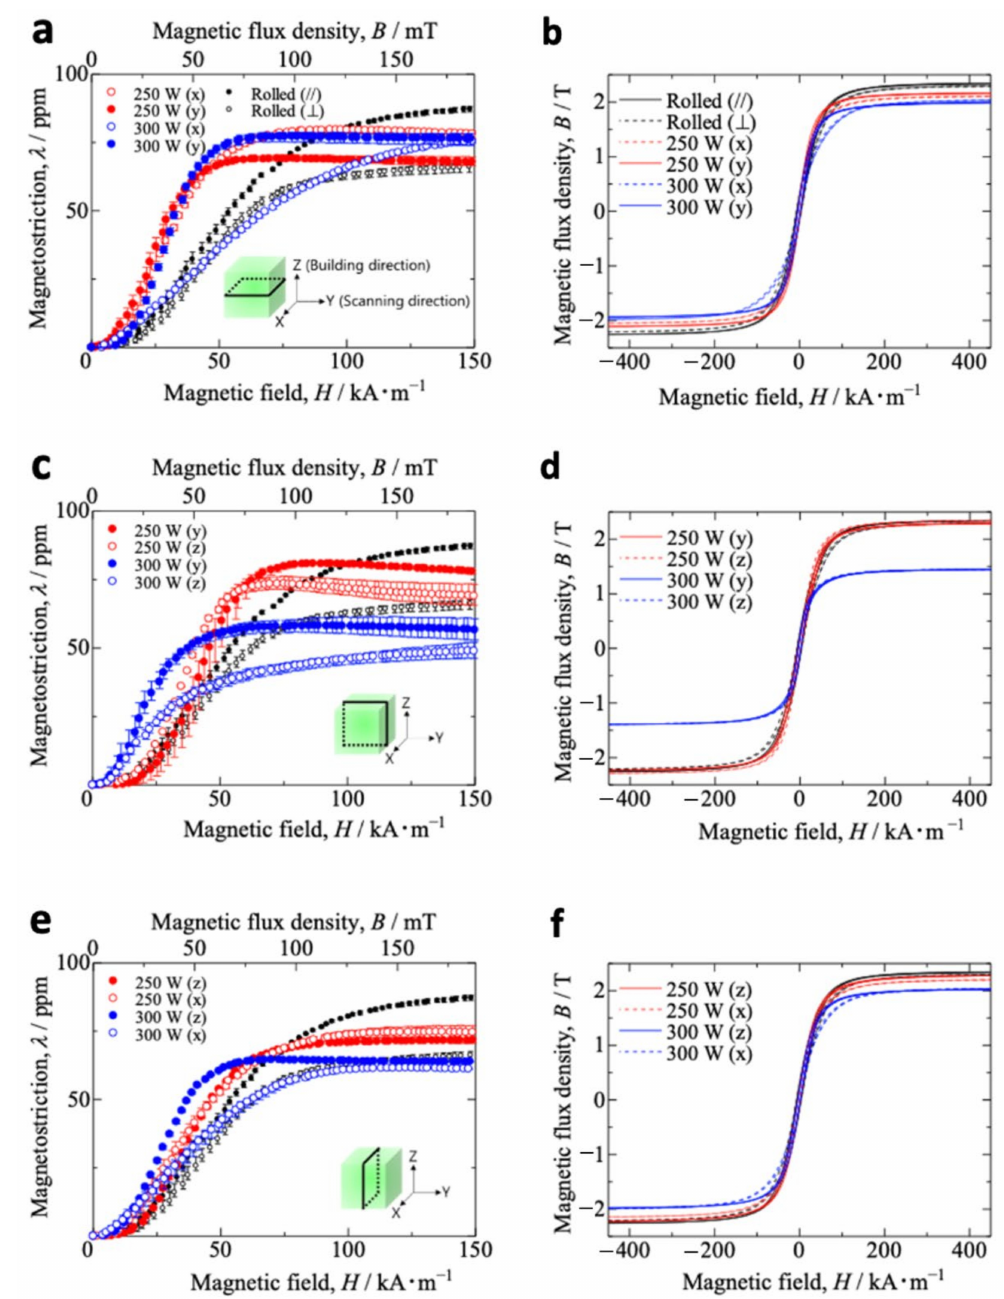
Figure 3. The results of magnetostriction λ vs. magnetic field H curves of additive-manufactured Fe–Co samples in the ( a ) x – y plane, ( c ) y – z plane, and ( e ) z – x plane. The results of the B – H curve of additive-manufactured Fe–Co samples in the ( b ) x – y plane, ( d ) y – z plane, and ( f ) z – x plane. The same sample was measured three times, and the mean was plotted. Error bars indicate standard